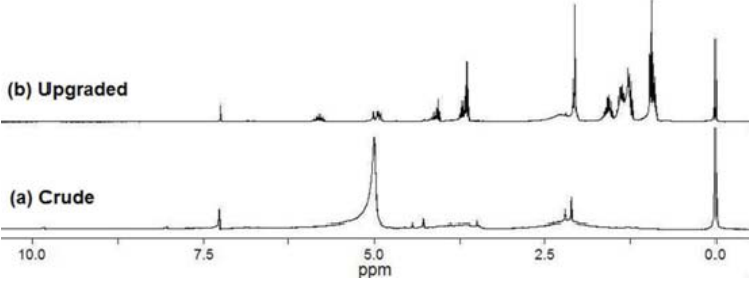
Figure 3. 1 H-NMR spectra of ( a ) crude bio-oil and ( b ) bio-oil upgraded with a bio-oil/ 1-octene/1-butanol wt ratio of 1.5/0.6/0.75 at 120 °C after 3 h over